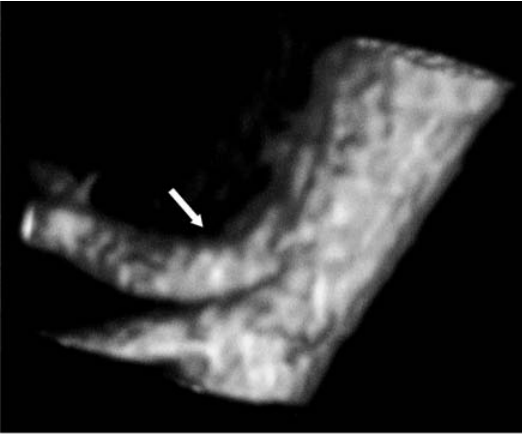
Figure 2 Extrinsic compression of the celiac axis during expiration.